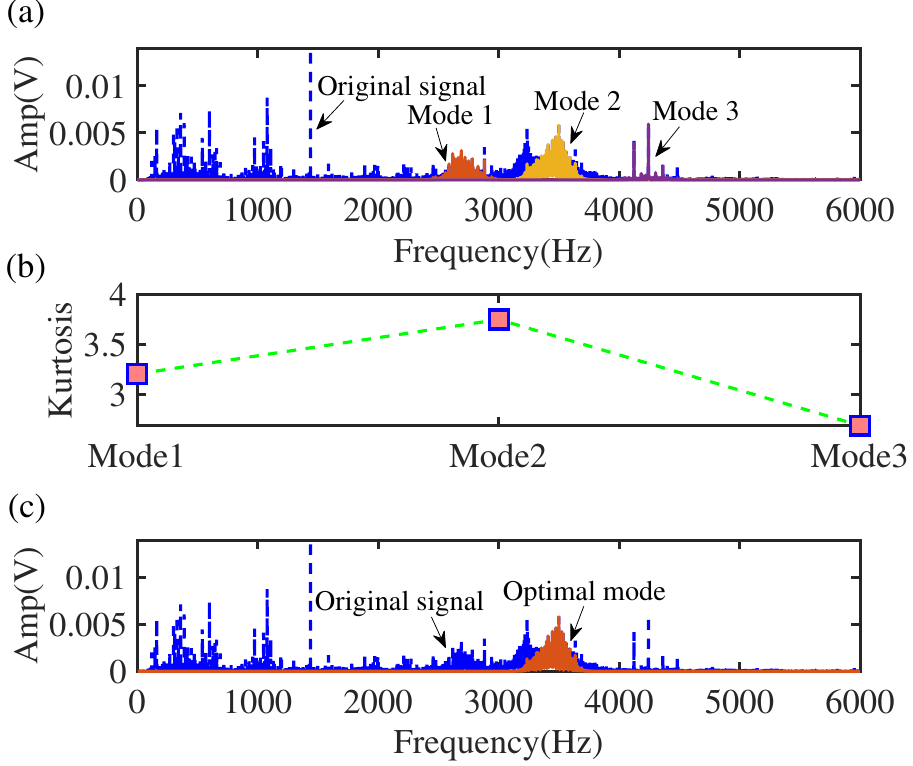
Figure 9. Extraction result by the proposed method: ( a ) extracted modes; ( b ) the kurtosis of different modes; ( c ) the optimal target